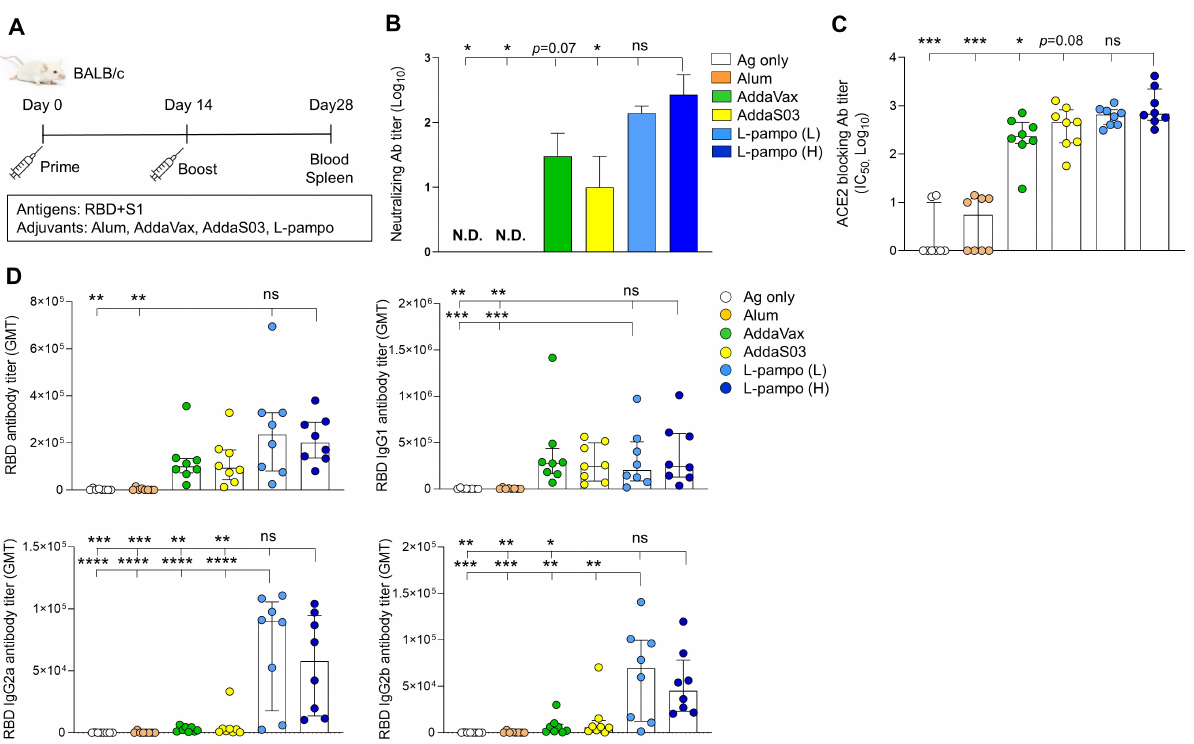
Figure 1. Receptor-binding domain (RBD) and S1 antigens with L-pampo induce robust humoral responses. ( A ) A schematic of immunization strategy. BALB/c mice (total n = 48; n = 8/group) were immunized with severe acute respiratory syndrome coronavirus 2 (SARS-CoV-2) antigens (RBD and S1) with or without adjuvants intramuscularly (i.m.) on day 0 and day 14. ( B ) Neutralizing antibody production on day 28. ( C ) Angiotensin-converting enzyme 2 (ACE2)-blocking antibody titers on day 28. ( D ) RBD-specific total IgG, IgG1, IgG2a, and IgG2b antibodies on day 28. Data shown are median ± Interquartile range (IQR). Each dot represents an individual mouse. GMT in antibody assay indicates geometric mean titers. Data reflect 2 independent experiments (n = 4/group in single experiment). Asterisks indicate statistically significant differences in comparison to the L-pampo (L) or L-pampo (H). * p < 0.05; ** p < 0.01; *** p < 0.001; **** p < 0.0001; ns, non-significant, one way ANOVA with the Tukey’s test.